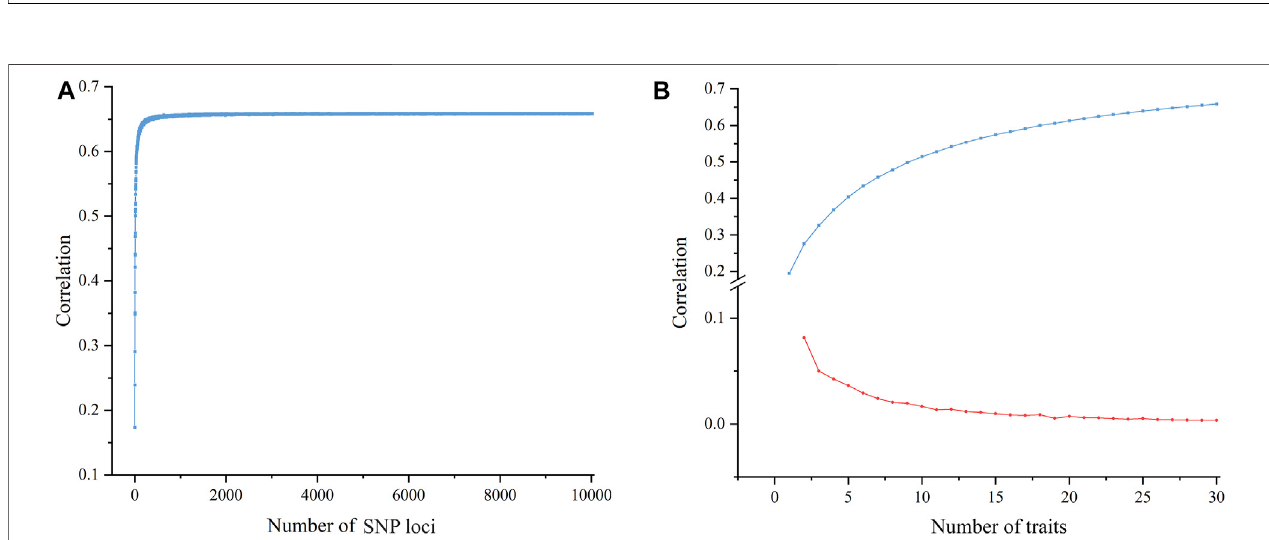
FIGURE 5 | Scatter plot of the effect of different numbers of SNPs and traits on the correlation. (A) A scatter plot of the correlation between molecular and phenotypic distances shows that the correlation improves as the number of SNP loci increases until a ceiling is reached. (B) A scatter plot of correlation between molecularand phenotypicdistancesshowsthecorrelationgrowth trendwithanincreasing number oftraits; thebluelineshowsagradual increase ofcorrelation and the red line shows a reduced increase.